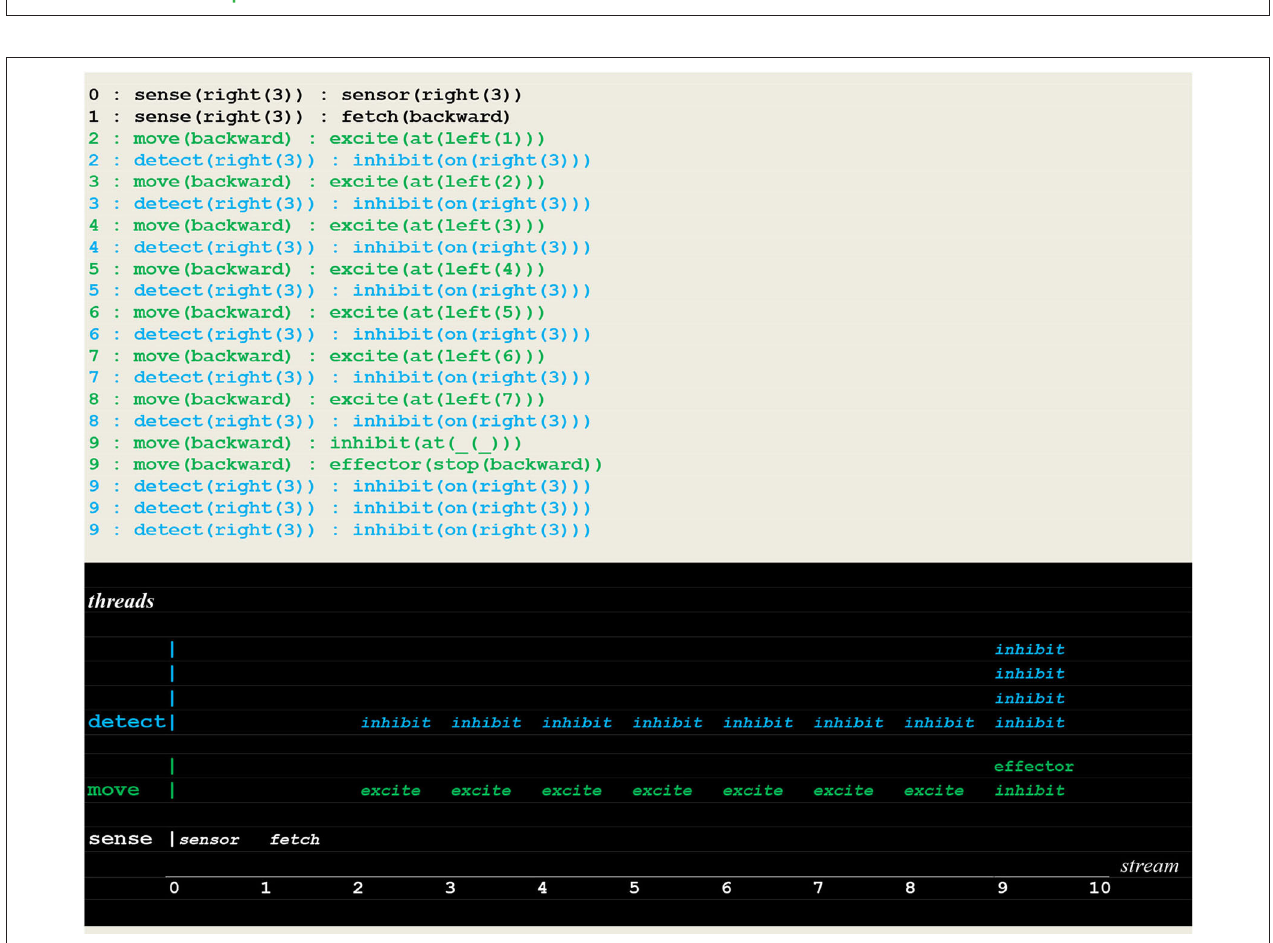
FIGURE 10 | Execution trace of the vehicle randomly moving in the wrong direction. Following an incorrect fetch(backward ) random choice, the detect and move concurrently produced a series of inhibit and excite stimuli until a single inhibit produced by the move thread at time 9 (signaling that the vehicle had reached the track limit) forced him to stop. At the same time, the detect threads went on producing inhibit stimuli (signaling that the fire had not been detected, and the detector not yet turned off).